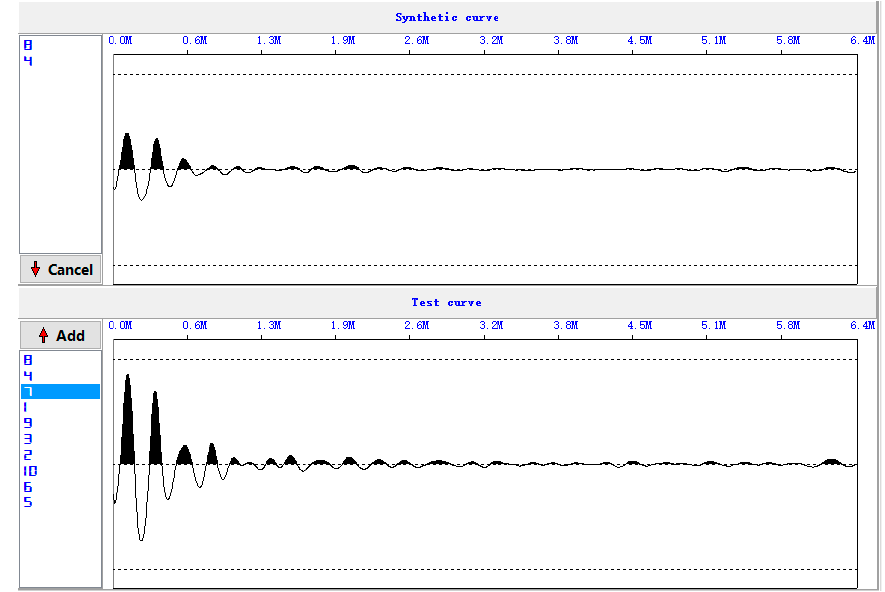
Figure 11. Superimposed waveforms at Site 1.